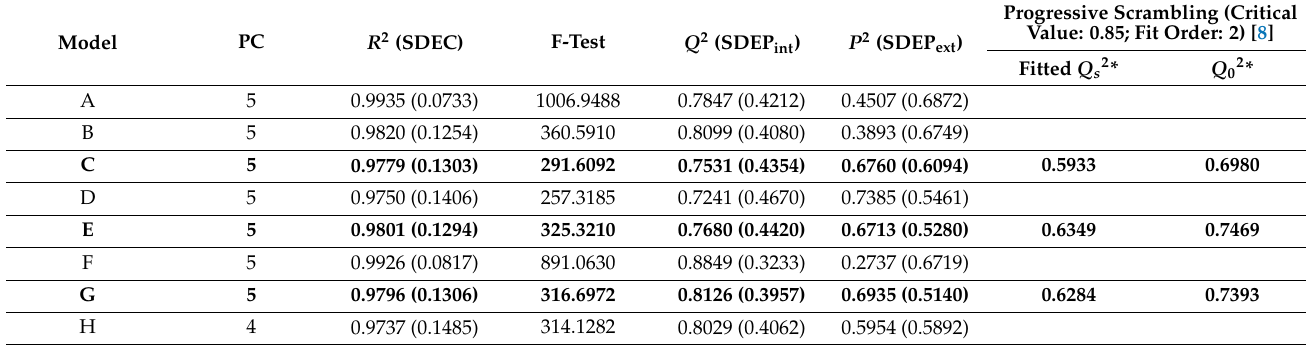
Figure 1. Molecular alignments generated before 3D-QSAR modeling: ( A ): manual alignment of lowest-energy conformers, based on superposition of the benzopyran core; ( B ): alignment based on pharmacophore properties generated with the Pharmacophore Elucidate function of MOE. The latter was used for the 3D-QSAR models. Table 2. Comparison of the statistical quality of the 3D-QSAR models obtained with the non-protonated molecules in alignment B (Figure 1) and 20 different training/test set divisions. For a detailed description of the training/test set divisions, see Table S1.